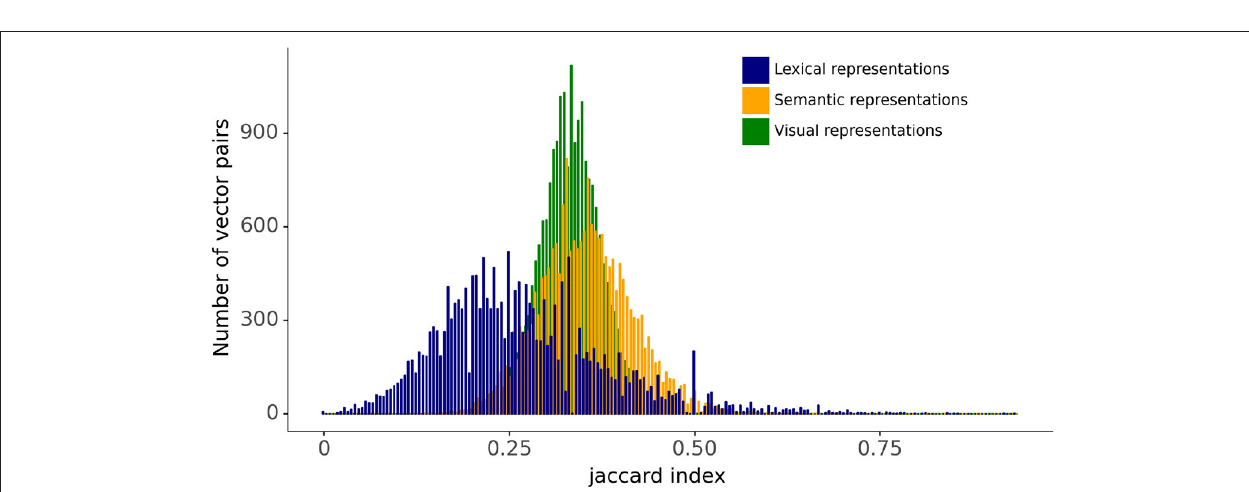
FIGURE 3 | Distributions for Jaccard index between pairs of lexical, semantic, and visual